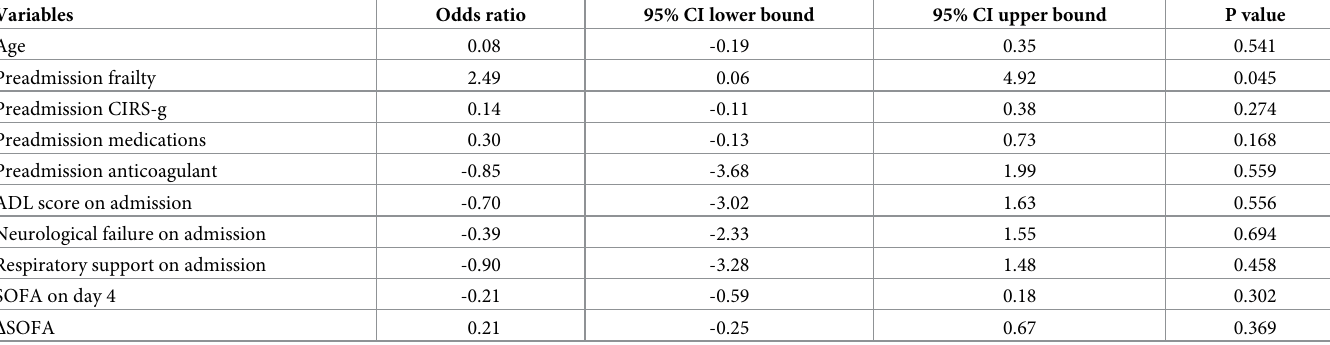
Table 4. Logistic regression model of loss of autonomy for patients who were still alive on day 90 including SOFA scores adjusted for independent covariates (pri- mary analysis with 49 patients). The loss of autonomy (change in [ Δ ] ADL) was calculated as ADL score at 90 days–ADL score on day 1, and was defined as Δ ADL < 0. The change in the SOFA score ( Δ SOFA) was calculated as SOFA score on day 1 –SOFA score on day